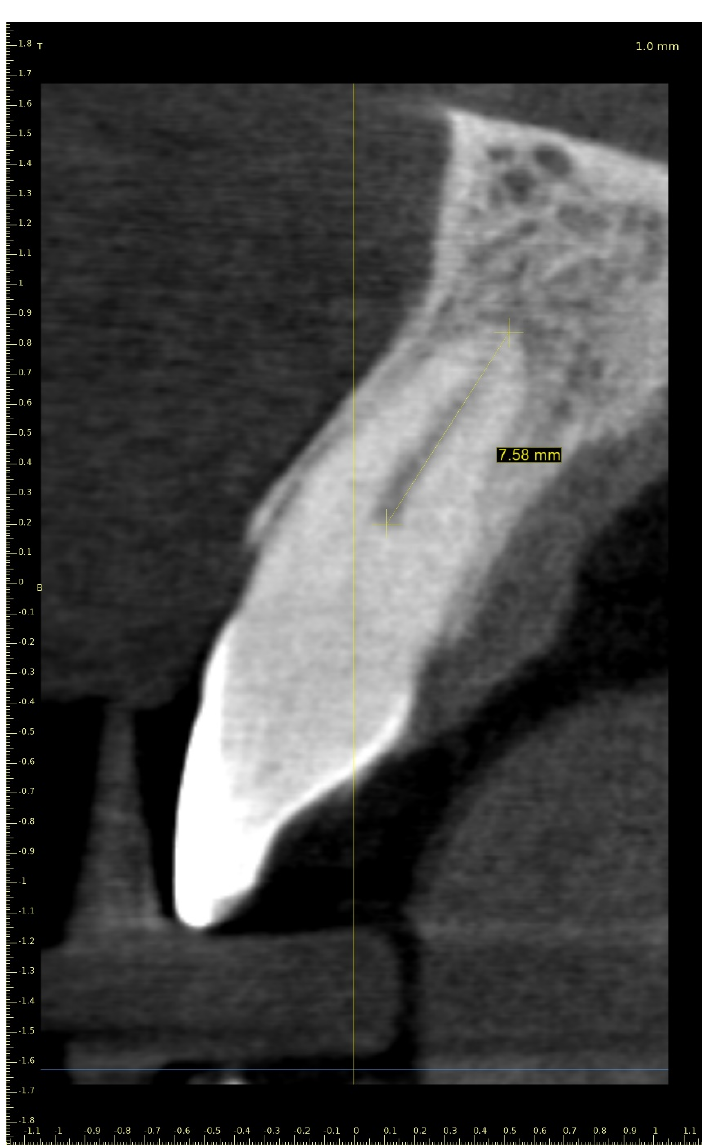
Figure 8. CBCT sagittal view image revealed a 7.58-mm-long visible part of the root canal on tooth 21 (FDI).